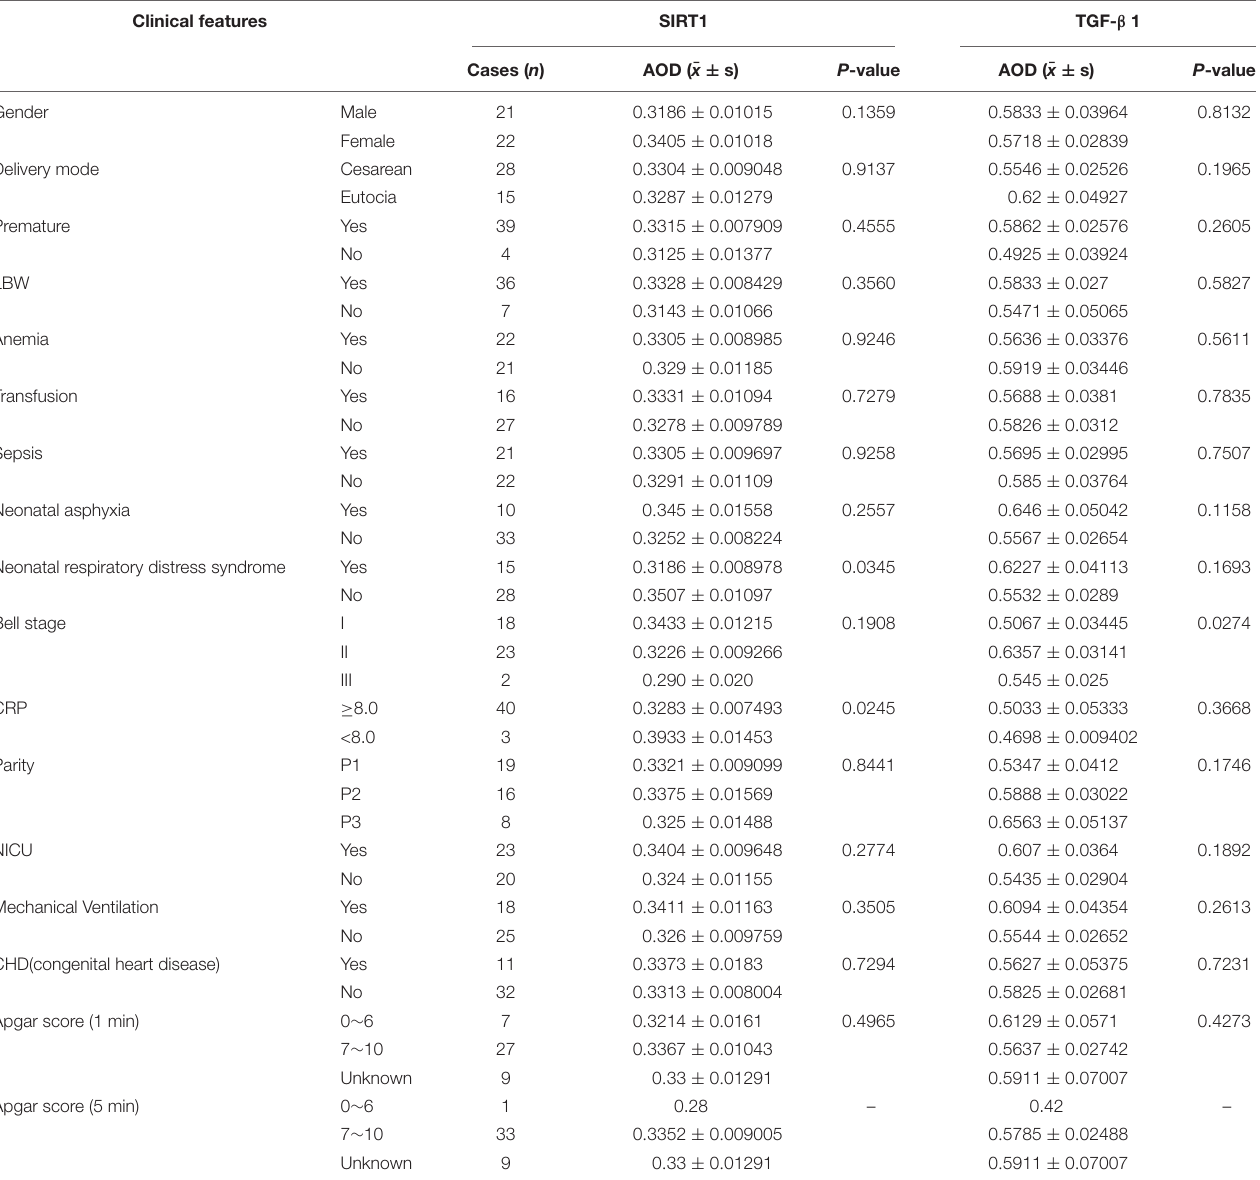
TABLE 3 | The relationship between Sirtuin1 or Silent mating–type information regulation 2 homolog-1 (SIRT1) and transforming growth factor- β 1 (TGF- β 1) protein expression and clinical features in mucous layer of post-necrotizing enterocolitis stricture tissues. Clinical